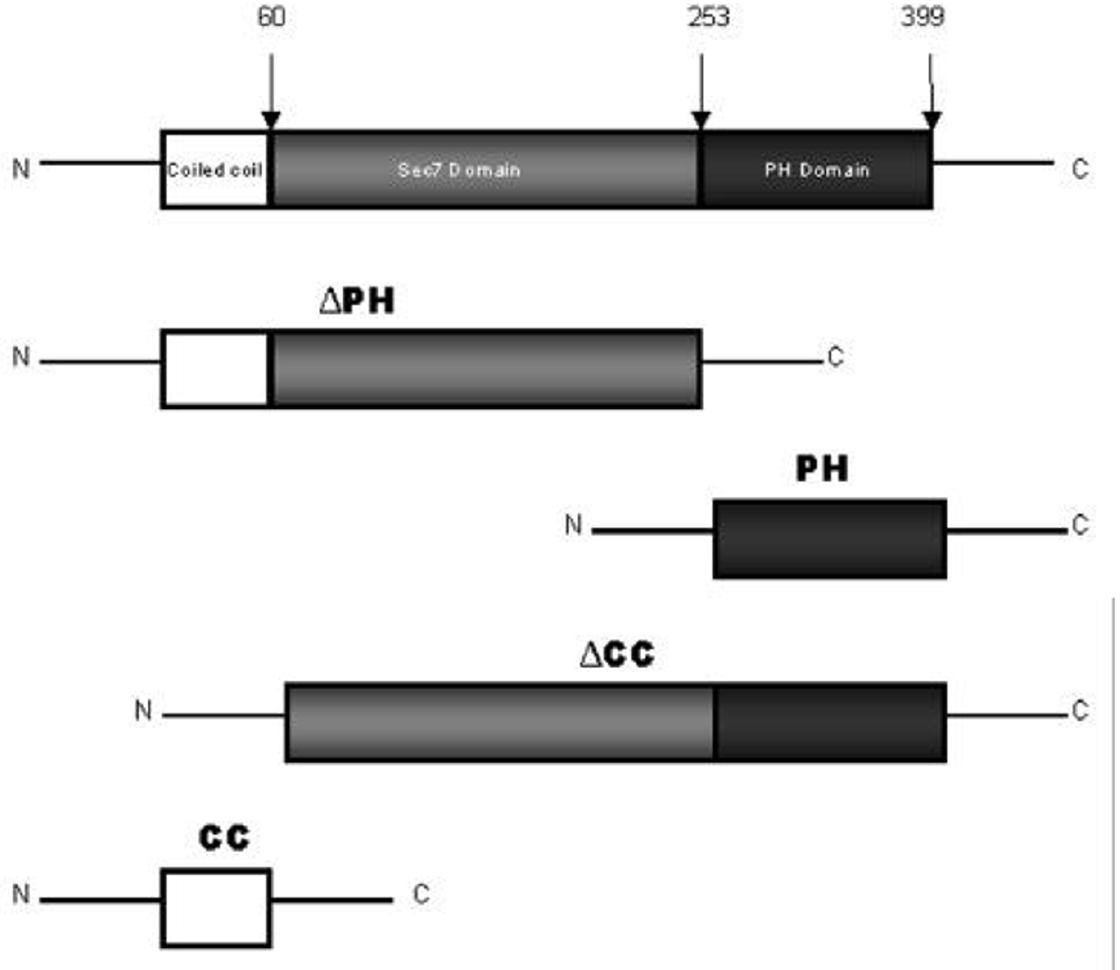
Schematic structure of ARNO constructs Figure